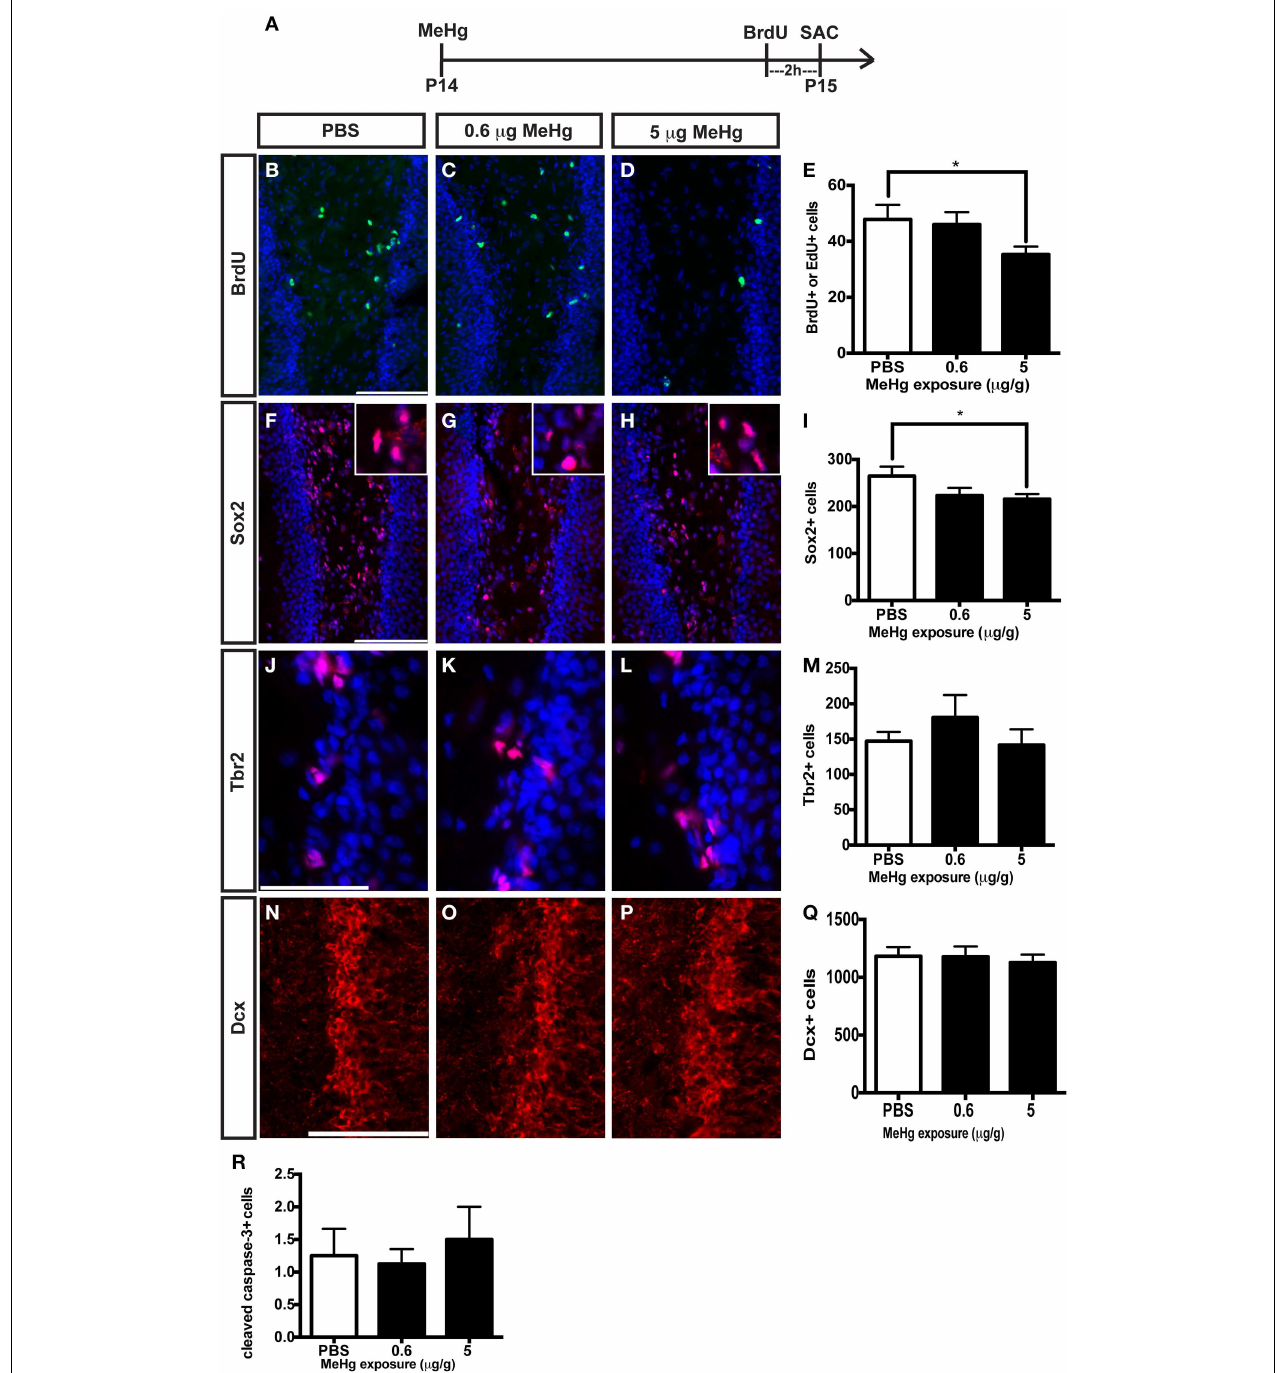
FIGURE 3 | S-phase cells and NSCs of the prepubescent (P14) hippocampus are vulnerable to acute MeHg exposure. (A) Experimental timeline. Five sections per brain were counted. (B–D) BrdU/EdU staining (green) in the hilus of the DG. Nuclei are labeled with DAPI (blue). (E) Quantification of the average number of BrdU + /EdU + cells per section per animal in the hilus. Animals: n = 10 per group. Each bar represents mean ± SEM. Scale bars: 100 µ m. (F–H) Sox2 staining (red) in the hilus of the DG. (I) Quantification of the average